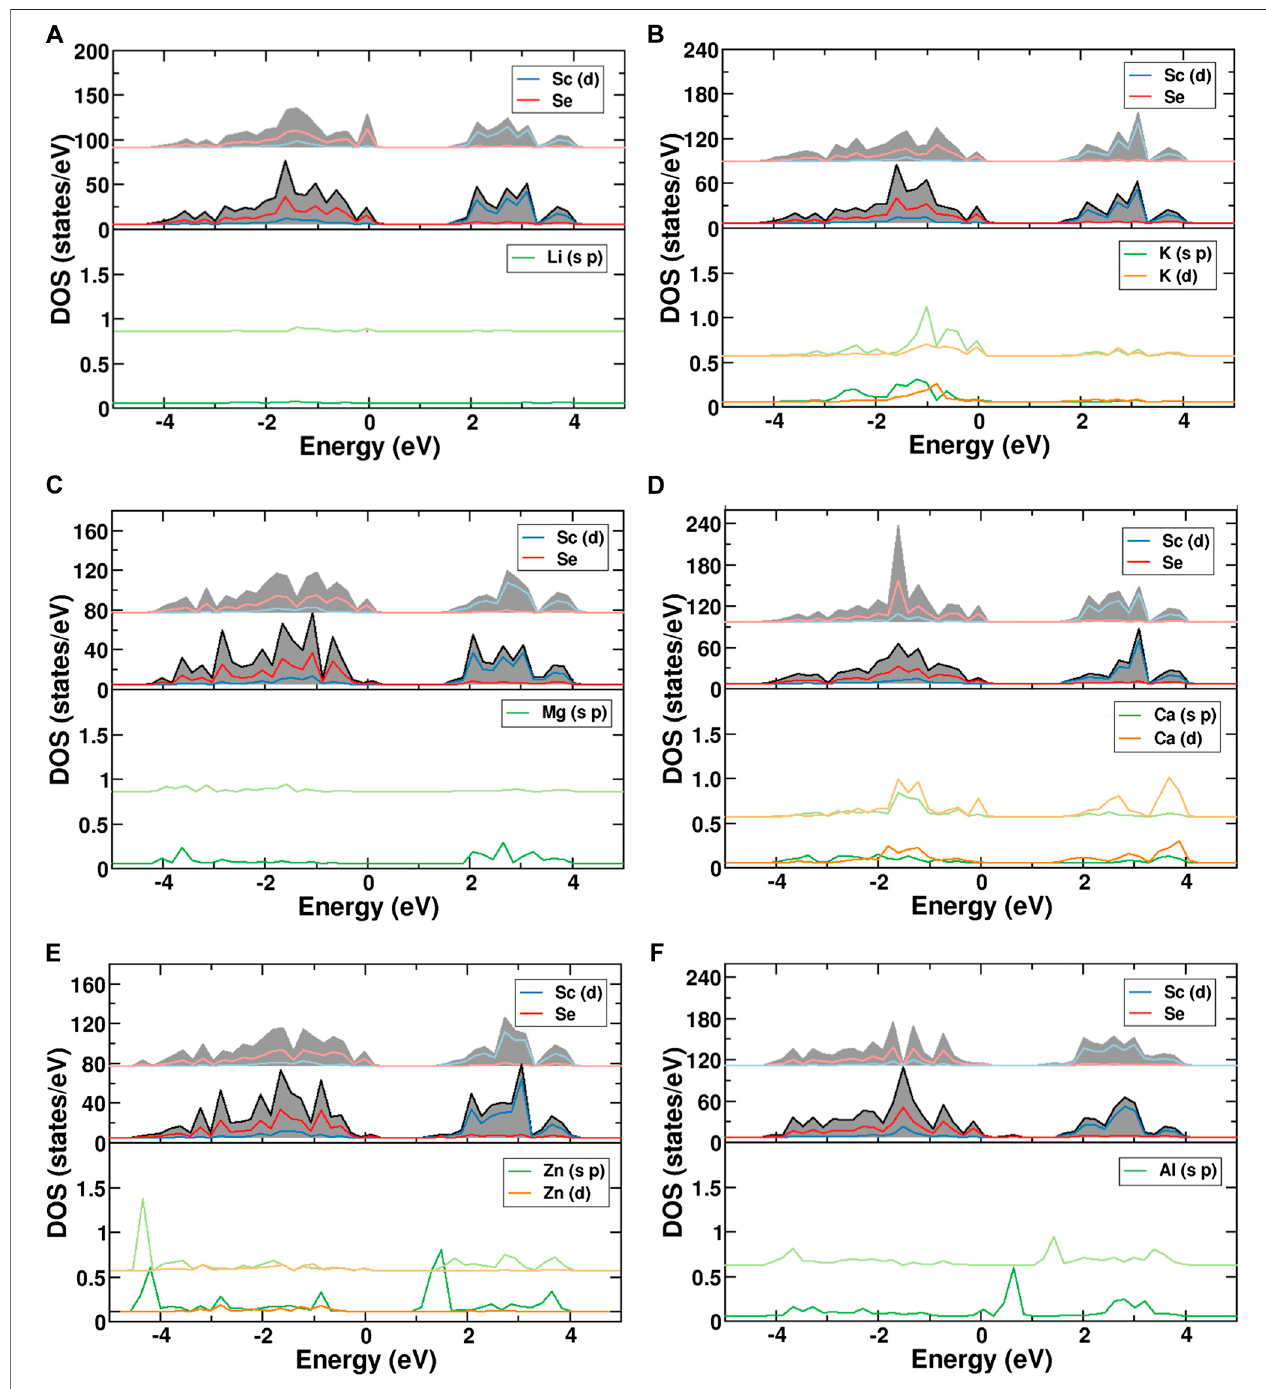
FIGURE 5 | PDOS of MgSc 2 Se 4 with (A) Li, (B) K, (C) Mg, (D) Ca, (E) Zn, and (F) Al atoms in octahedral and tetrahedral coordination. The DOS of the ion in tetrahedral coordination (light color) is shifted upwards relative to the DOS of the ion in octahedral coordination (dark color).